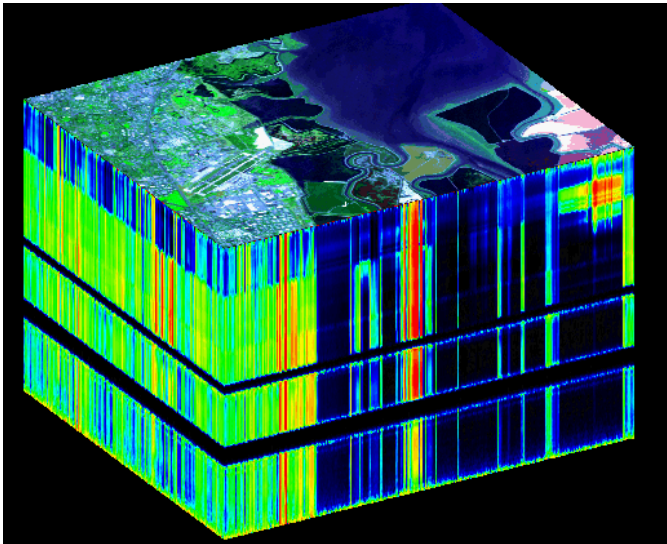
Figure 8. Airborne hyperspectral image cube of Moffett Field, California. The image was collected on 20 August 1992 from a height of 20,000 m [59].